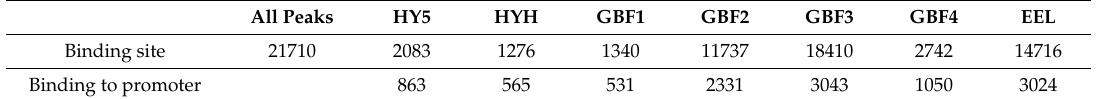
Table 1. Numbers of binding sites of seven bZIP